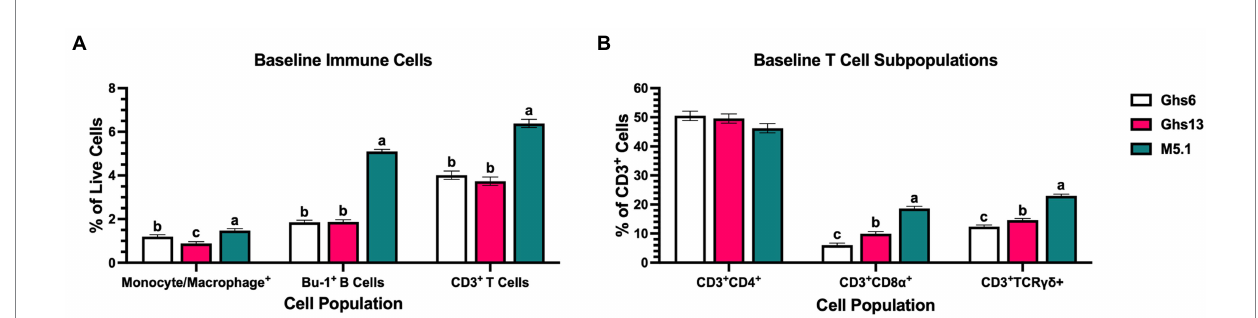
FIGURE 4 Baseline immune cell proportions as a percentage of peripheral blood mononuclear cells in Leghorn (Ghs6 and Ghs13) and Fayoumi (M5.1) inbred genetic lines before inoculation with 10X Coccivac-B52 (Merck Animal Health, Kenilworth, NJ). Analyzed immune cells comprise (A) monocyte/ macrophage, Bu-1 + B, and CD3 + T cells in addition to (B) underlying CD4 + helper, CD8 α + cytotoxic, and TCR γδ + T cell subpopulations. Data represent the mean population of cells positive for each marker within the (A) live cell or (B) CD3 + cell gates ( n = 10 birds/genetic line) ± SEM. Bars with different letter labels are significantly different, p ≤ 0.05.